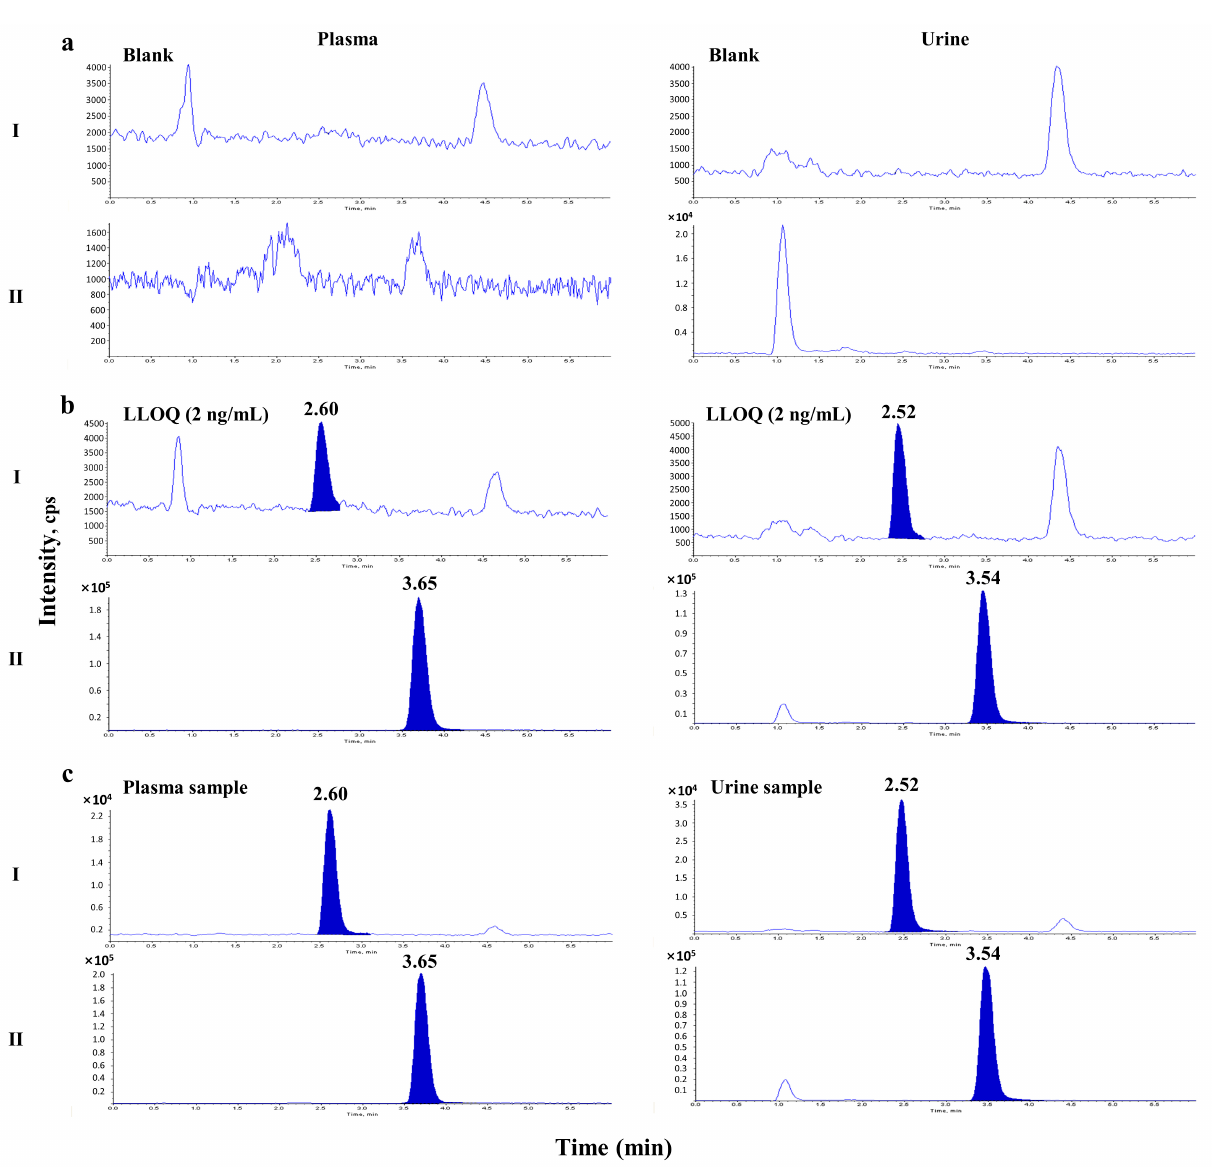
Figure 2. Representative chromatograms of benzisothiazolinone (BIT) ( Ⅰ ) and phenacetin (IS) ( Ⅱ ) in plasma and urine: ( a ) double blank plasma or urine; ( b ) blank plasma or urine spiked with BIT at the LLOQ (2 ng/mL for plasma and urine) and the IS; ( c ) a plasma sample from 90 min after intravenous injection of 10 mg/kg BIT and a urine sample collected from 0 to 24 h after intravenous injection of 10 mg/kg BIT.